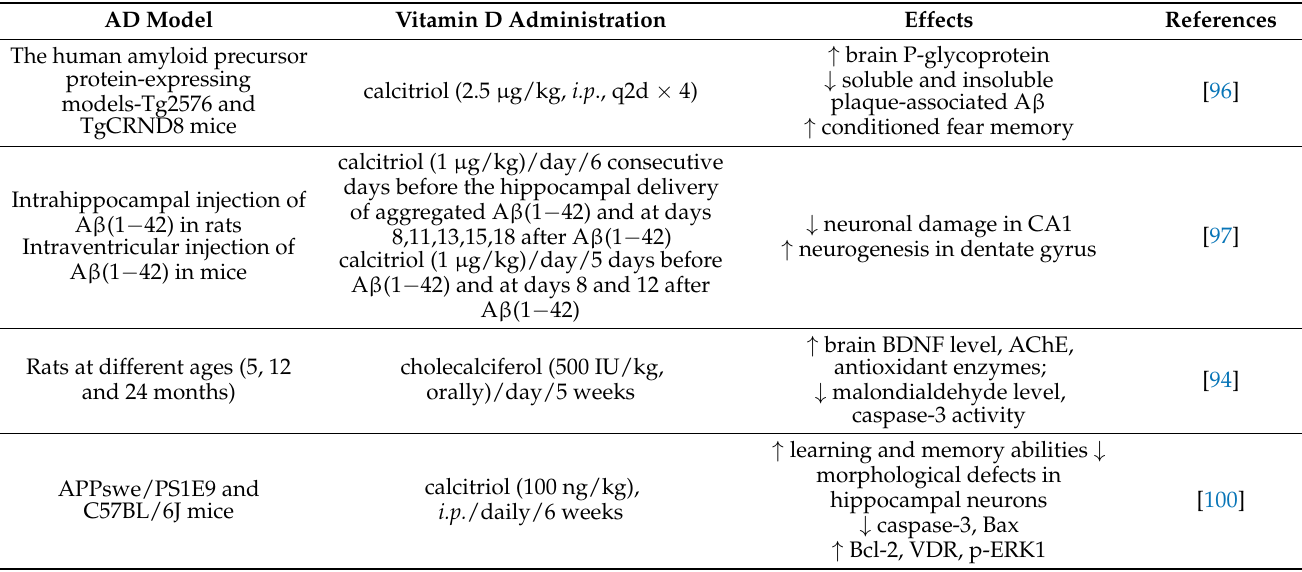
Table 2. Effects of vitamin D in experimental models of Alzheimer’s disease—in vivo